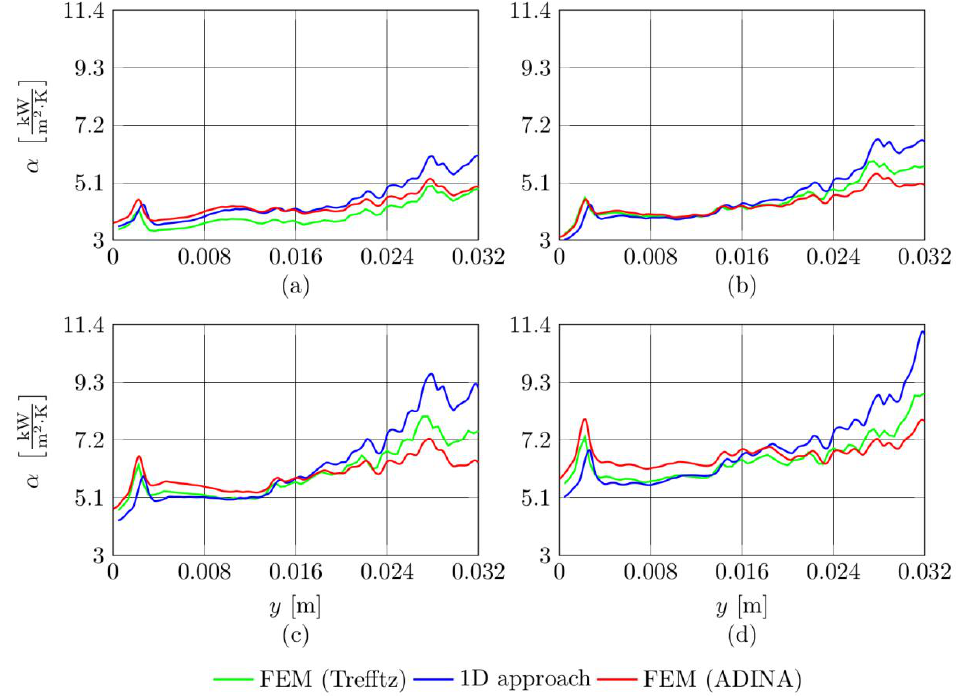
Figure 14. Heat transfer coefficient vs. the distance from the minichannel inlet determined from the FEM computations using the Trefftz functions (green line), ADINA software (red line) and according to the 1D approach (blue line); the test section with three minichannels; experimental parameters listed in Table 2, heat flux values: ( a ) q’’ = 68 kW/m 2 ; ( b ) q’’ = 75.7 kW/m 2 ; ( c ) q’’ = 100.2 kW/m 2 ; ( d ) q’’ = 123.5 kW/m 2 .